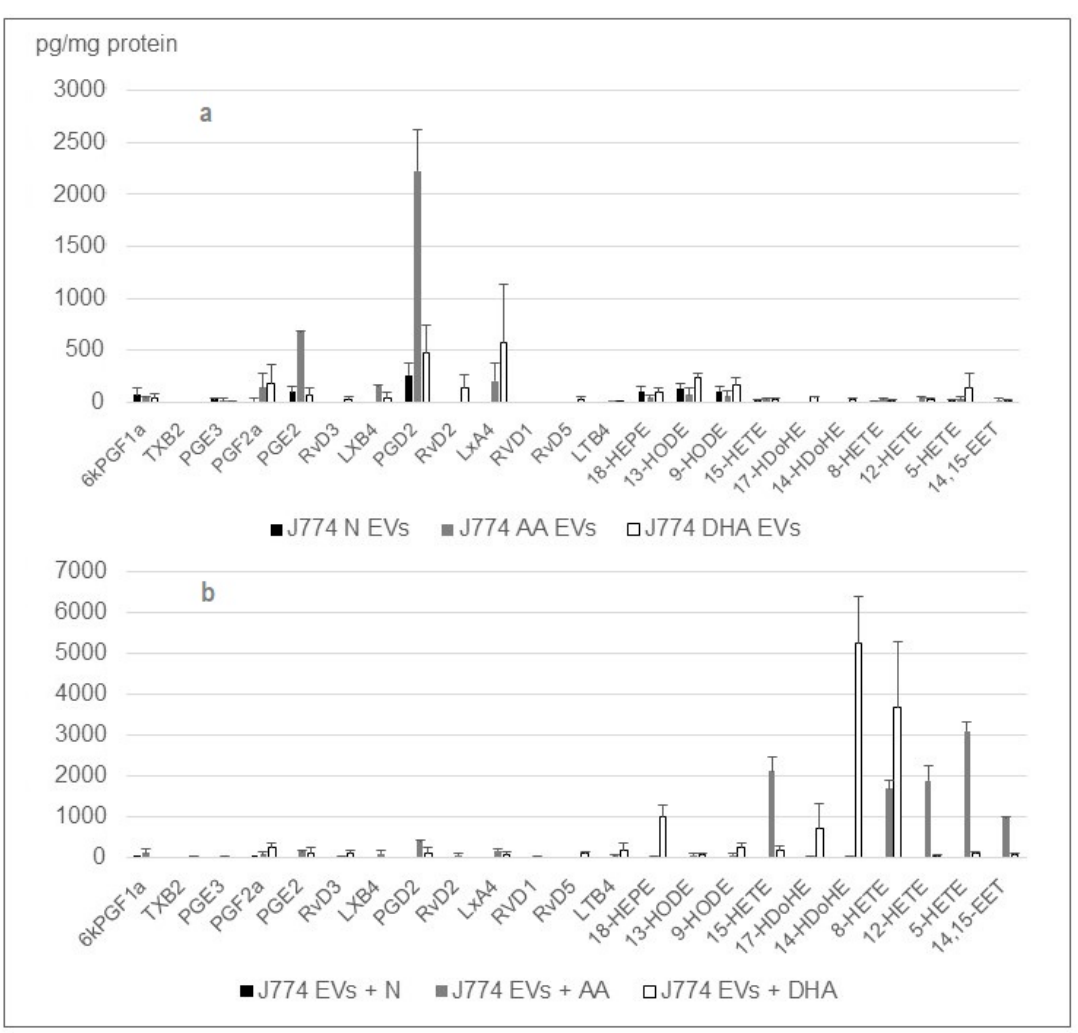
Figure 7. Comparison between the lipid mediator profiles embedded in ( a ) small EVs released by J774 cultured in the presence of PUFAs and ( b ) small EVs released by J774 cultured in DMEM 1% FBS that were incubated after collection in DMEM supplemented with PUFAs. Number or replicate was three.